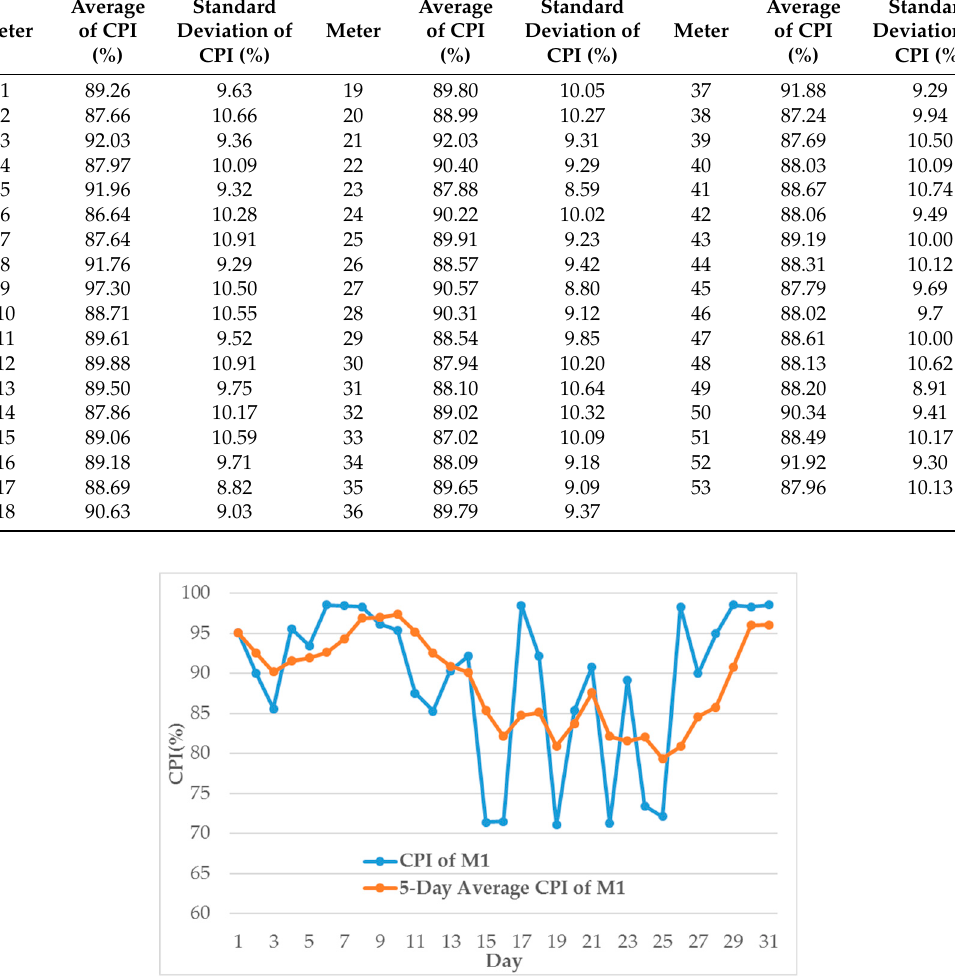
Figure 19. CPIs and 5-Day Average CPIs of Smart Meter M 1 .